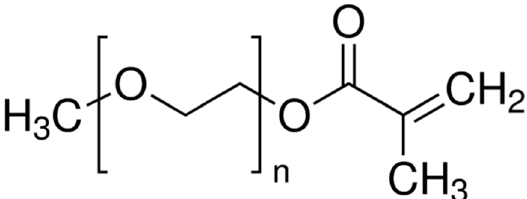
Figure 3. Poly(ethylene glycol) methyl ether methacrylate (PEGMA) chemical structure.